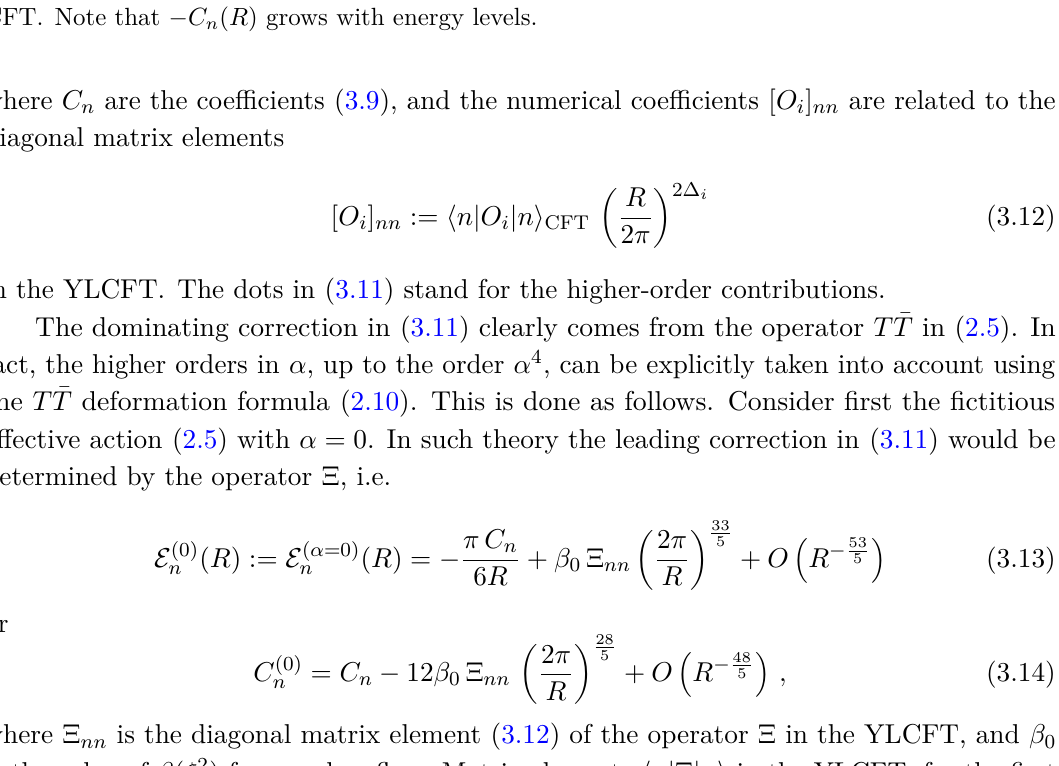
Figure 6 . Plots of the − C n ( R ) at ξ 2 = − 0 . 035846 , the dashed lines show − C n from the infrared CFT. Note that − C n ( R ) grows with energy